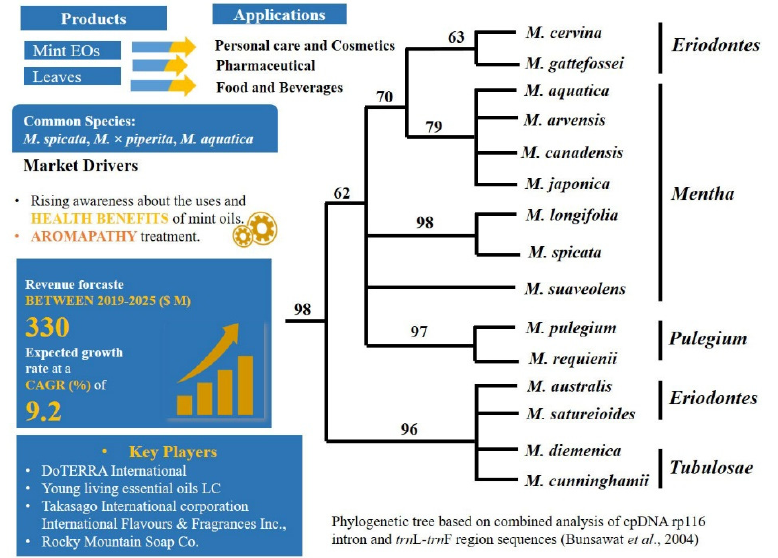
Figure 2. Mintproducts market analysis [120] and phylogenetic relationship among the